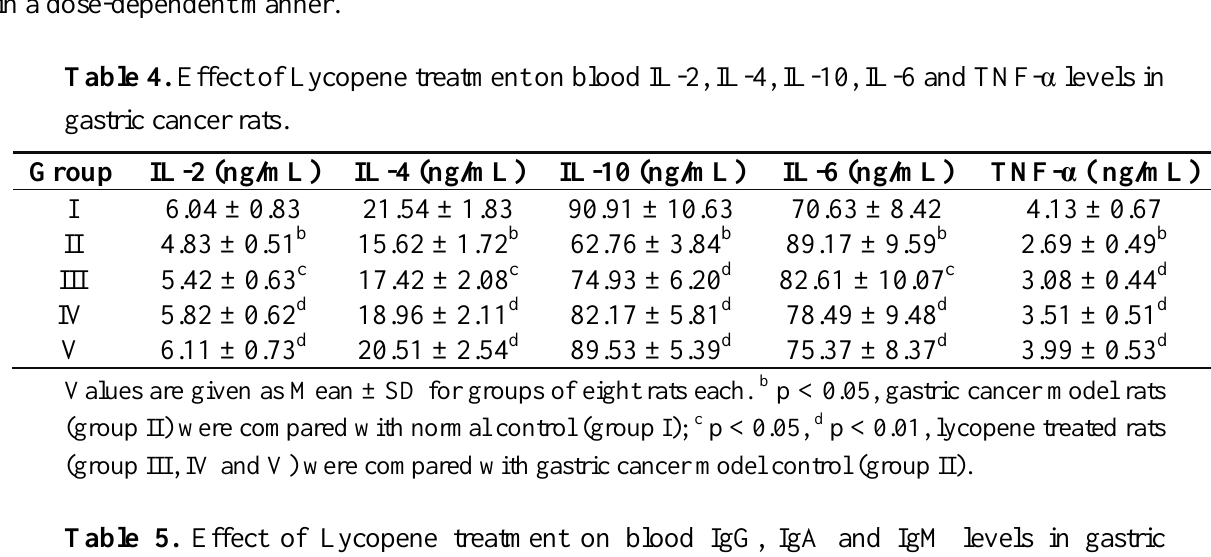
Table 5. Effect of Lycopene treatment on blood IgG, IgA and IgM levels in